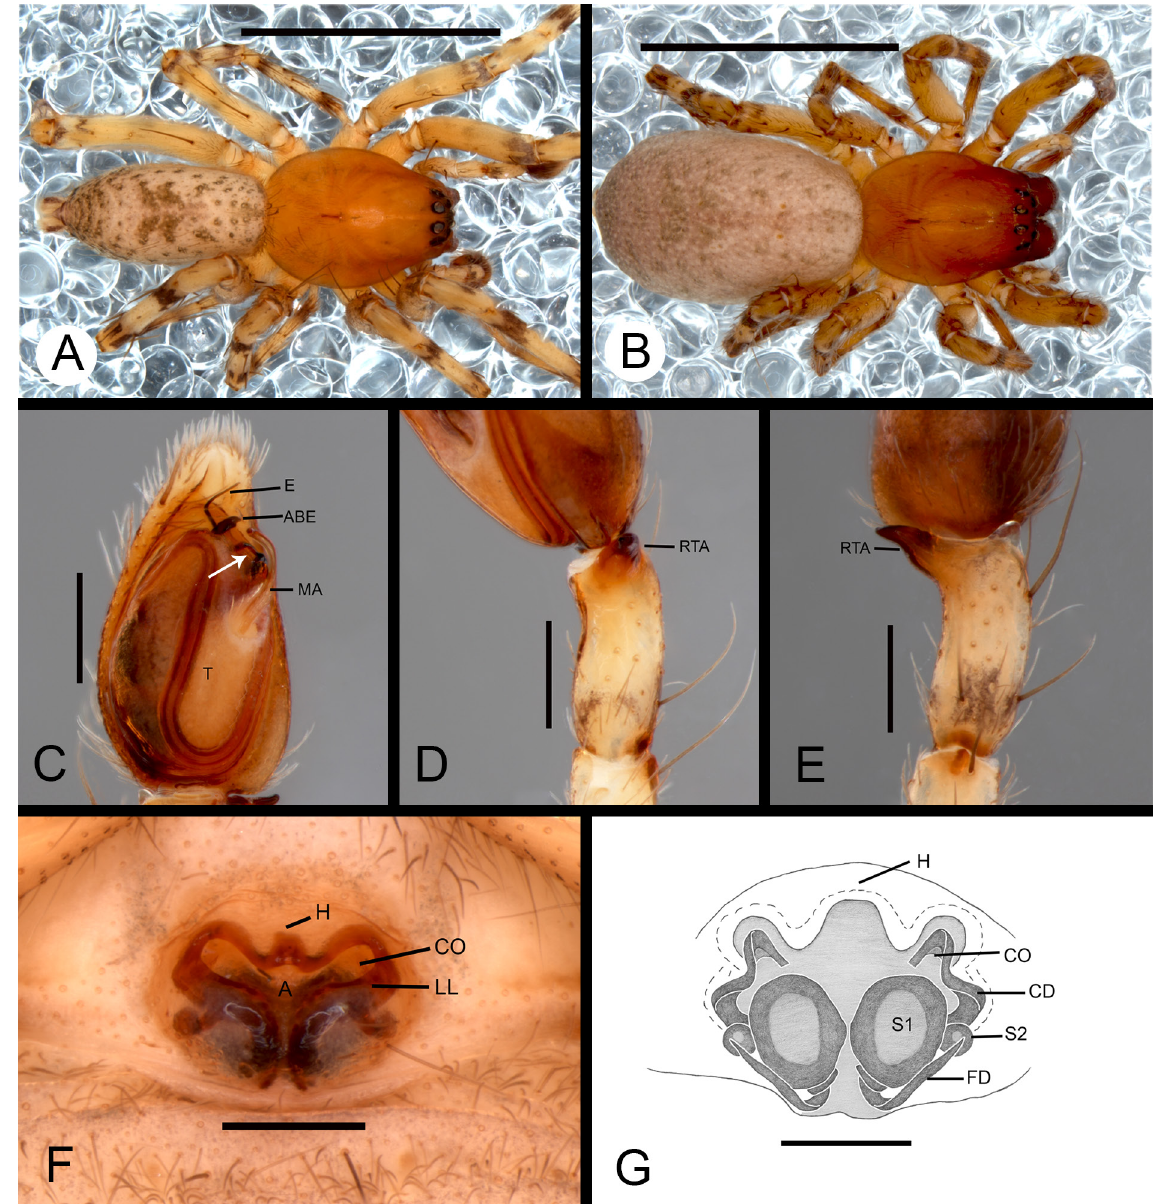
Fig. 19. Tafana huatanay sp. nov. (A, C–E = holotype, ♂, MUSM B, F–G = paratype, ♀, MUSM). A . Habitus, dorsal view. B . Habitus, dorsal view. C . Left palp, ventral view (arrow indicating the base of the embolus). D . Left palp, retrolateral view. E . Left palp, dorsal view. F . Epigynum, ventral view. G . Vulva, dorsal view. Abbreviations: A = atrium; ABE = apophysis of base of the embolus; CD = copulatory ducts; CO = copulatory opening; E = embolus; FD = fertilization ducts; H = hood; LL = lateral lobes; MA = median apophysis; RTA = retrolateral tibial apophysis; S1 = primary spermathecae; S2 = secondary spermathecae; T = tegulum. Scale bars: A–B = 2.16 mm; C–G = 0.25